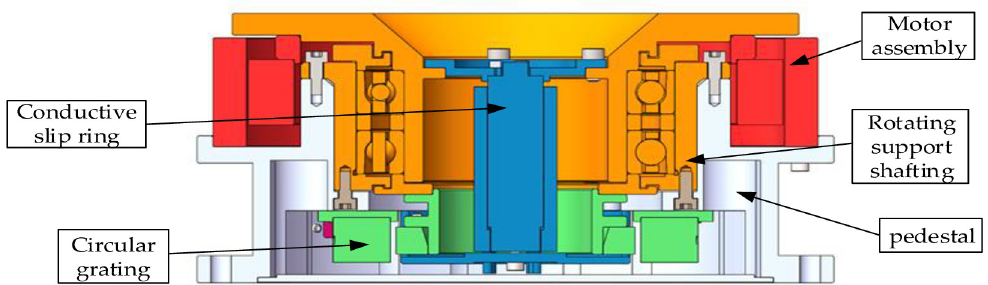
Fig 5. Schematic diagram of the SGCMG rotating